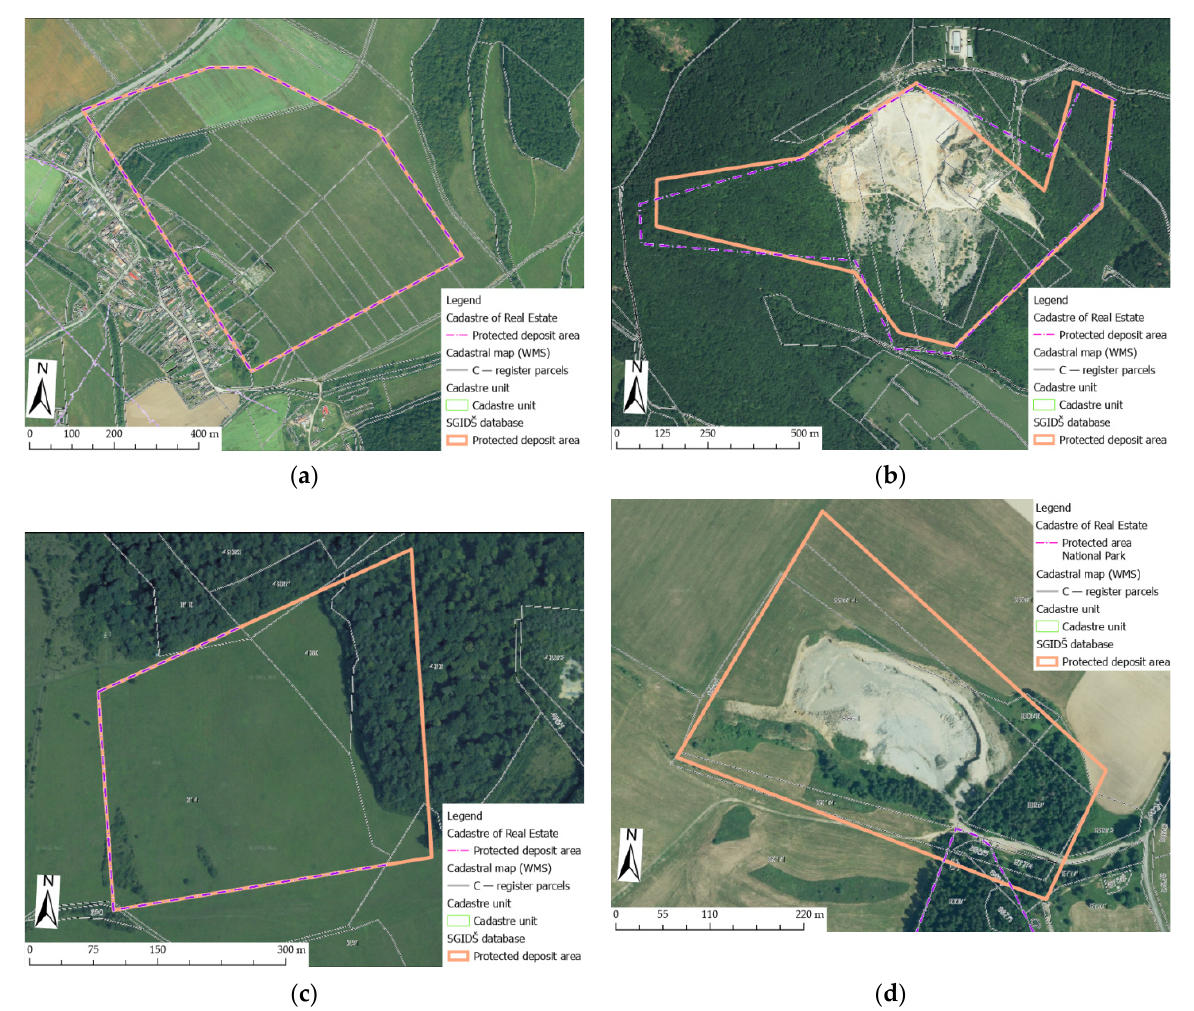
Figure 6. Cases of comparison of PDA registration data: ( a ) PDA is registered in both systems; ( b ) non-identical PDA boundary; ( c ) registration of PDA at the boundary of two c.u.; ( d ) missing PDA boundary in the